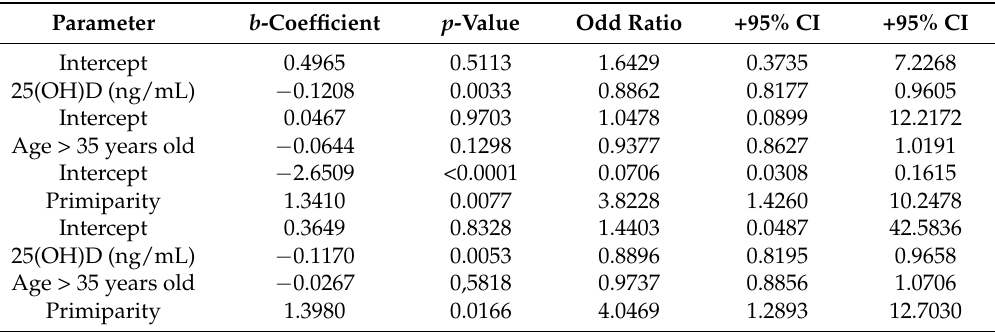
Table 4. Results of univariate and multivariate logistic regression analysis examining the effects of serum 25(OH)D levels (ng/mL), age and primiparity on the incidence of preeclampsia. Parameter b